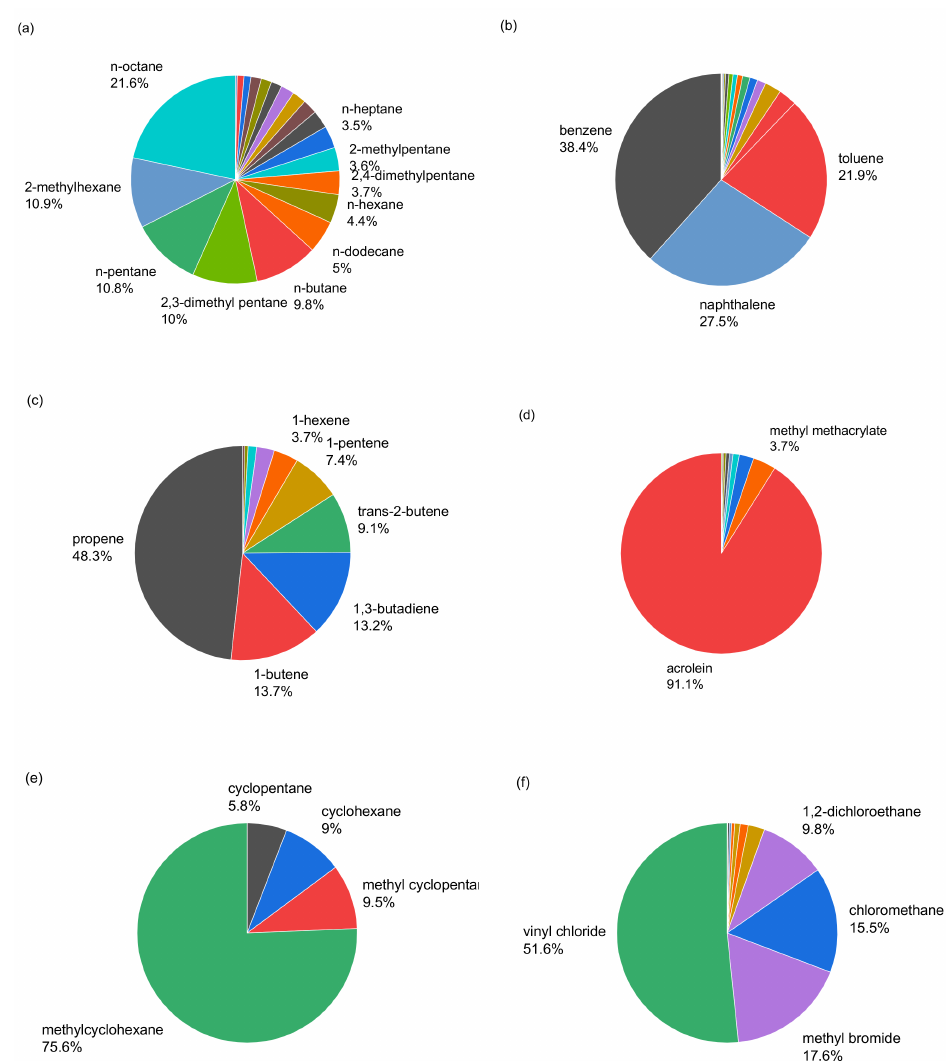
Figure 3. OFP of the cement kiln stack gas ( a ) Alkane; ( b ) Aromatic; ( c ) Alkene; ( d ) O-VOCs; ( e ) Cycloalkane; ( f )